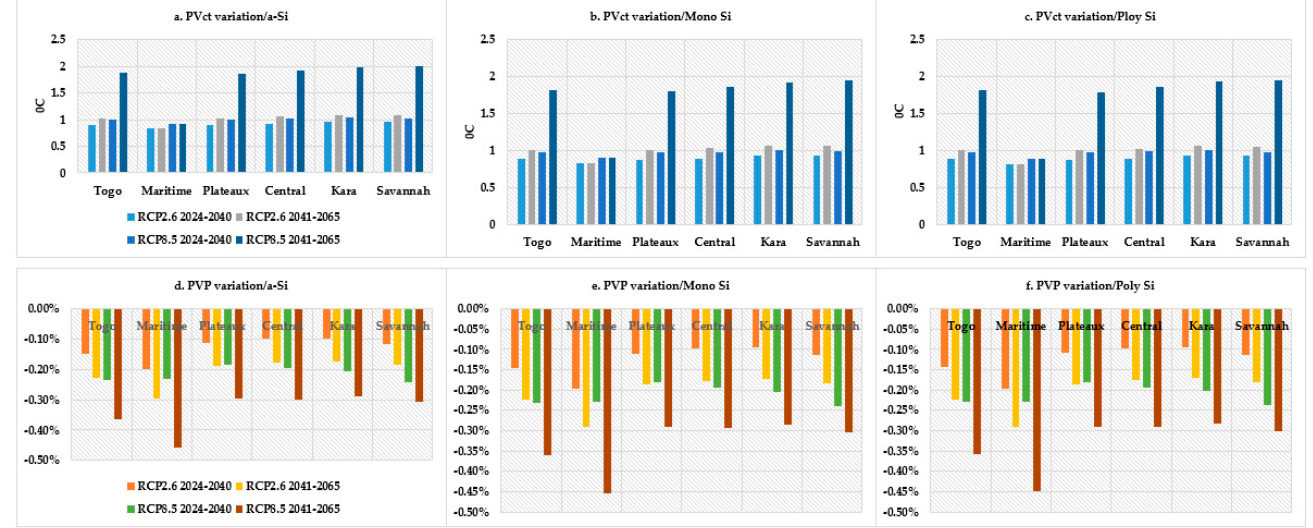
Figure 11. Summary of climate change on solar energy (PVct and PVP) under RCP2.6 and 8.5 as a result of PV cell technology usage 2024–2065 (near and middle futures).